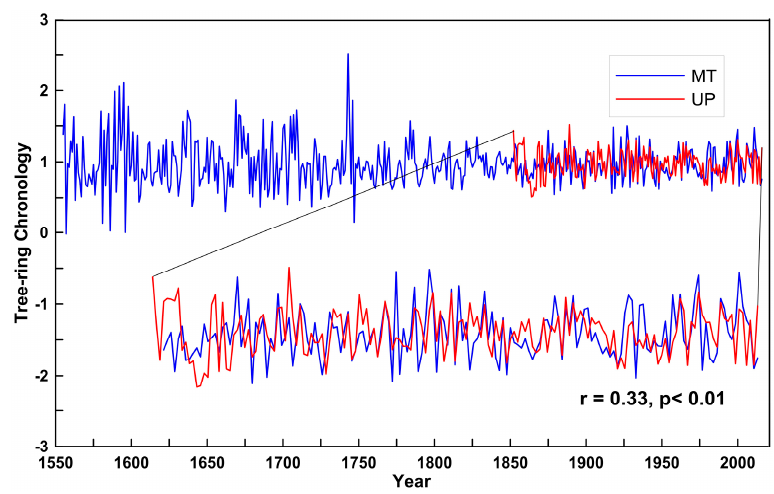
Figure 3. Correlation coefficients among teak tree-ring chronologies.